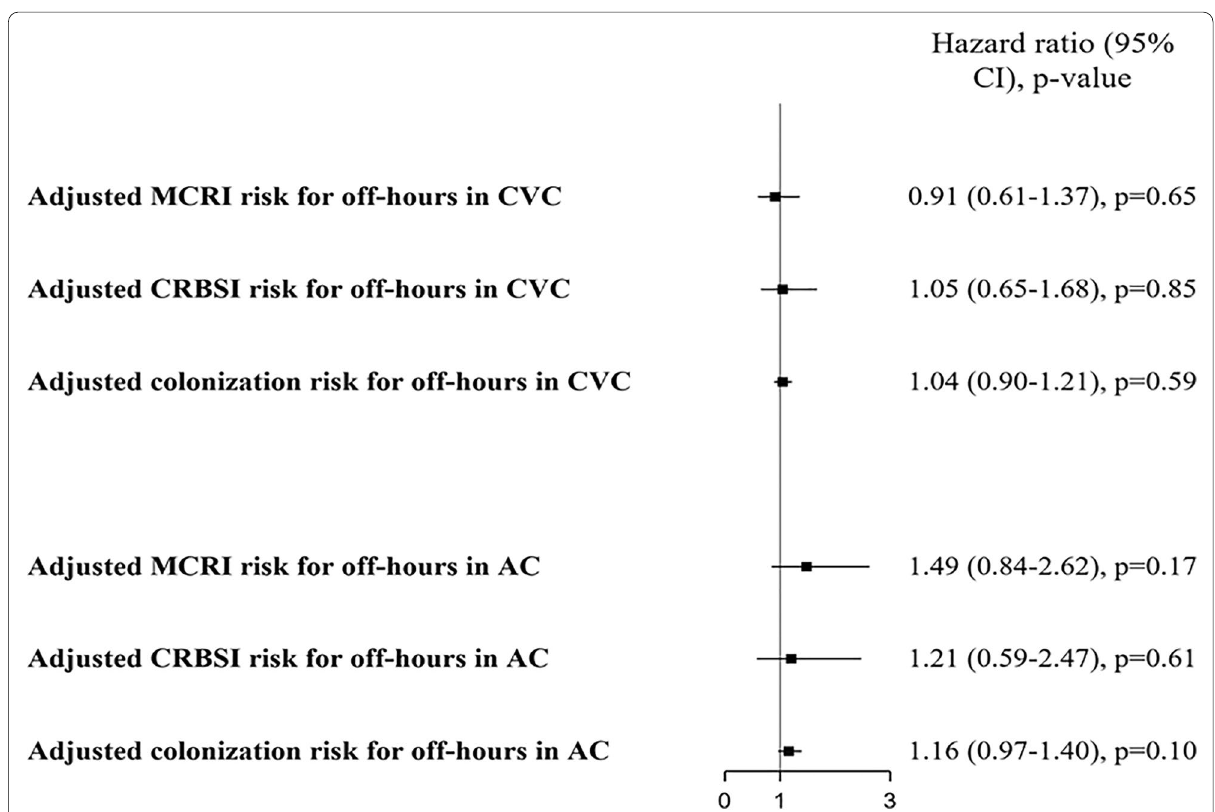
Fig. 2 Adjusted MCRI, CRBSI and colonization hazard risk for off‑hours in CVCs and ACs. CI: confidence interval. MCRI: major catheter‑related